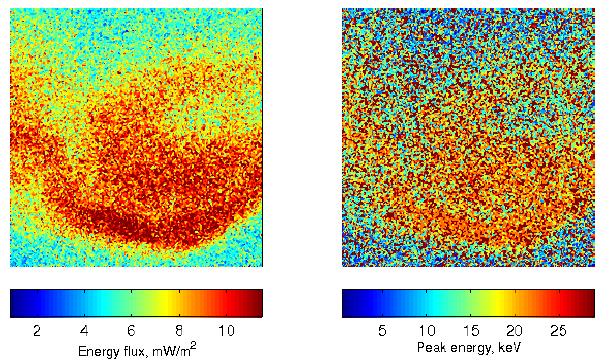
Fig. 11. Images of ASK 1 and measured OI/N 2 ratio at 18:08:09, converted into energy flux and peak energy